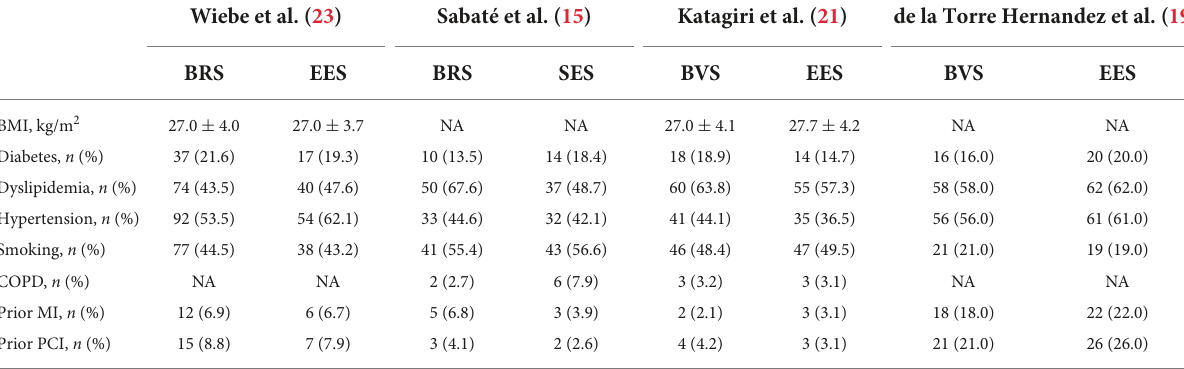
TABLE 2 Clinical characteristics of included trials.